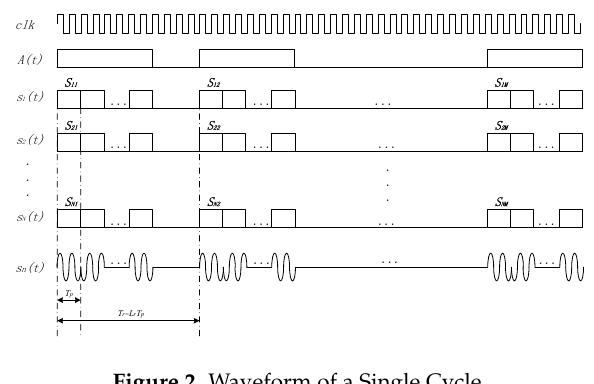
Figure 2. Waveform of a Single Cycle.